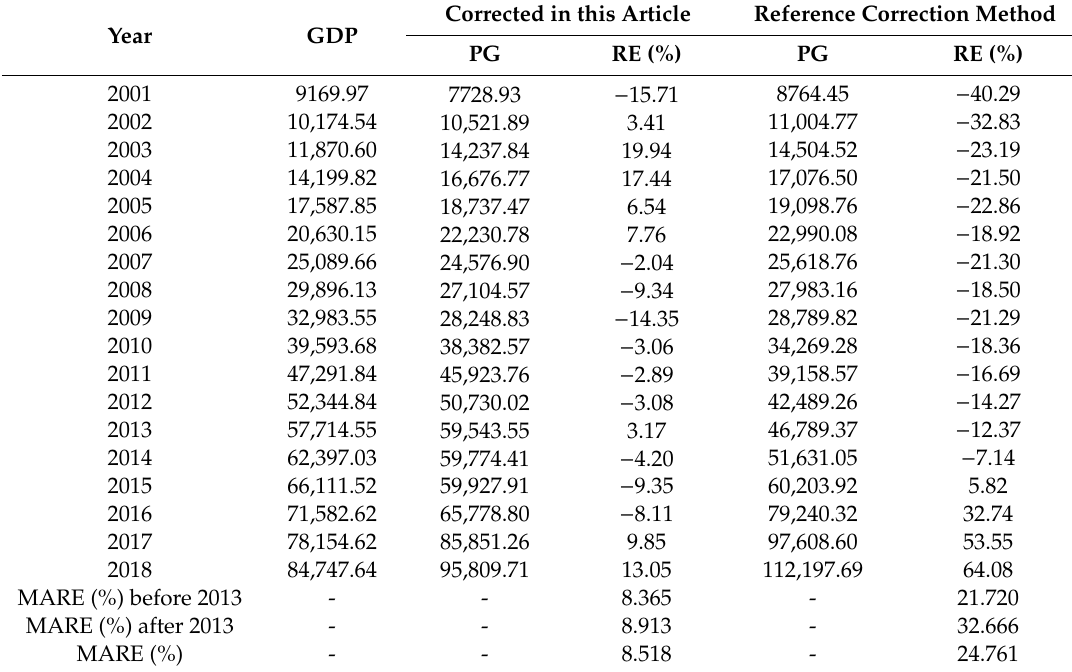
Table 3. Accuracy of the estimated gross domestic product (GDP) by the established power function on time series at the national scale.